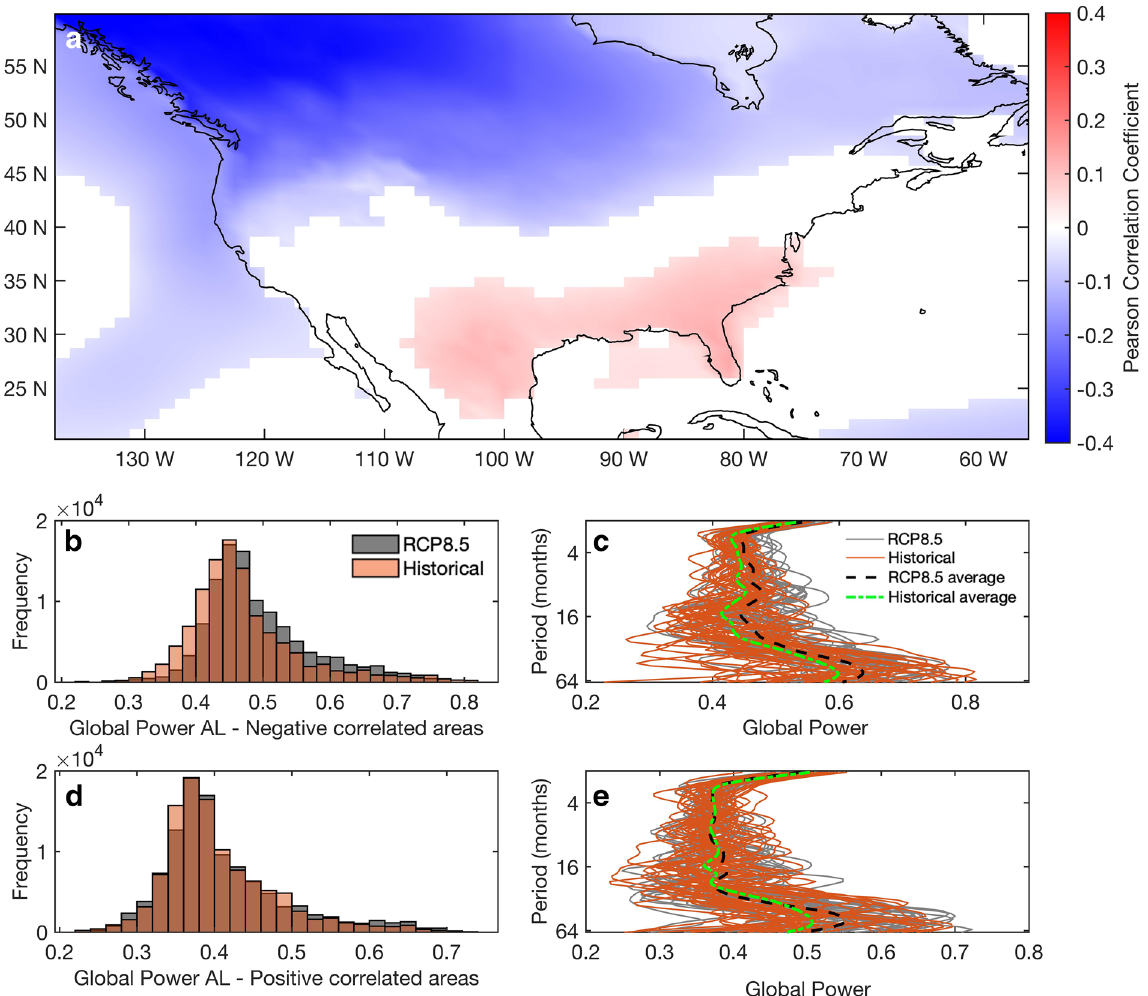
Figure 3. ( a ) Point-wise Spearman correlation coefficient between the spatially averaged historical and RCP8.5 AL SLP and SAT in north America ( b ) The frequency distribution of the global power of wavelet coherence between the past and future simulations of the negatively correlated areas (shown in (a)) between the spatial average of the AL SLP over the area 45°–65° N, 160° E–140 W and surface air temperature over North America. ( c ) The global power of the 36 past (orange lines) and the future (grey lines) ensemble members. Black and green dashed lines represent the average global power of future and past multi-ensemble members respectively. ( d ) Same as ( b ) but for positively correlated areas. ( e ) Same as ( c ) but for positive correlations between AL SLP and SAT. Map figure was created using Matlab 38